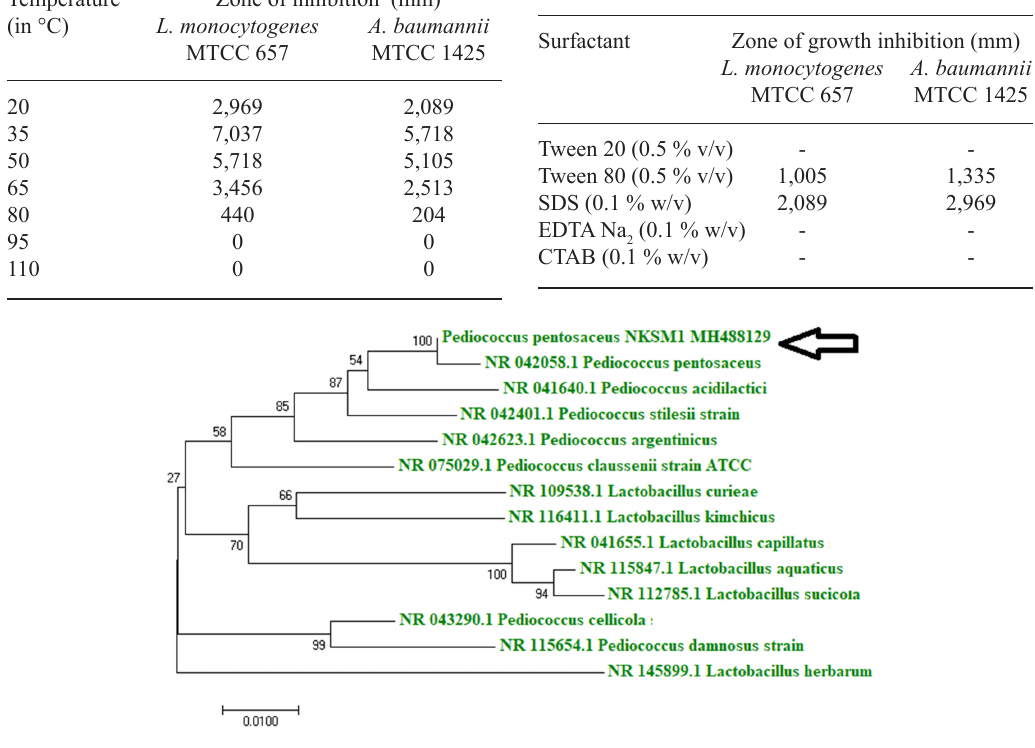
Fig. 1. Phylogenetic tree showing the taxonomic position of P. pentosaceus NKSM 1